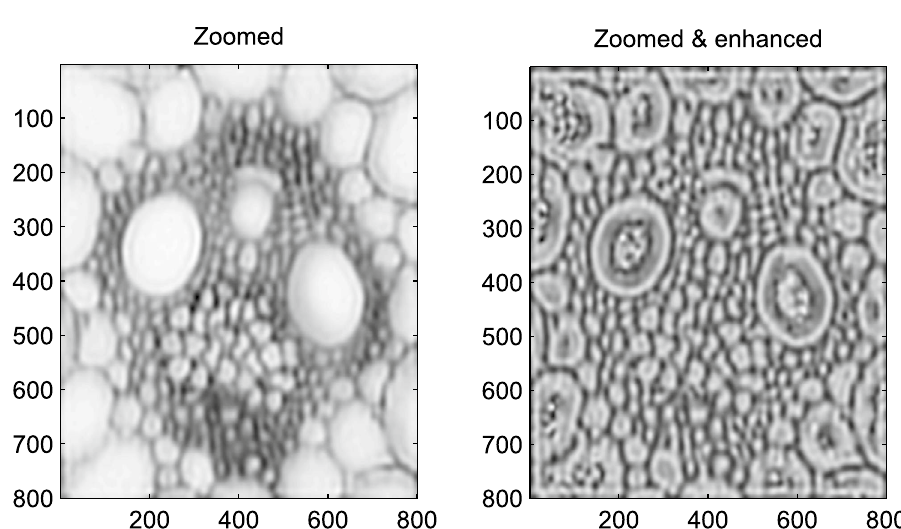
Figure 11. Contrast enhancement with asymmetric smoothing, applies to the stem cross section image. Left panel: zoomed image. Right panel: after